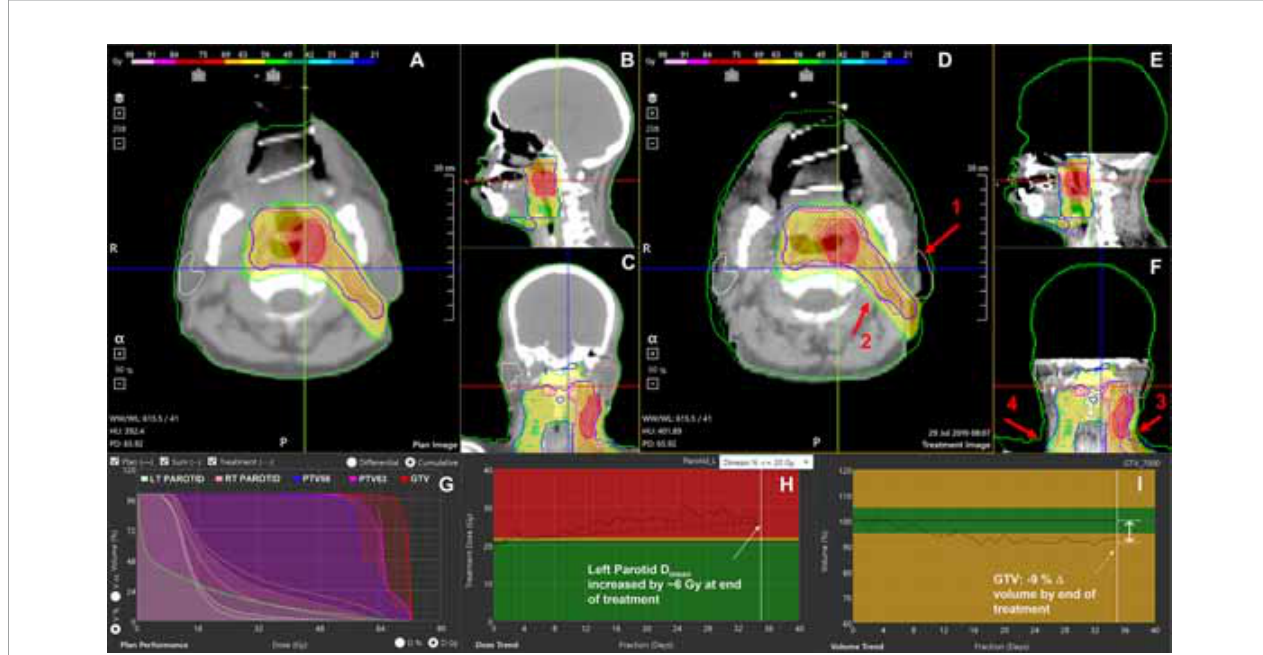
FIGURE 1 | RTapp software user interface. (A – C) Initial plan CT, structures, and 3D dose. (D – F) The fi nal fraction ’ s CBCT with plan structures (solid line), deformed contours to current day ’ s position (dotted line), and initial 3D dose. (G) DVH showing the plan dose (solid line), delivered dose up to the current fraction (DVH sum , dotted line), and day of treatment dose scaled to full treatment (DVH day , dashed line). (H) Trend for parotid ’ s mean dose; (I) tumor volume regression throughout the treatment. The red arrows indicate notable effects of RT and weight loss on the left parotid (1), PTVs (2), external neck contour (3), and inconsistent shoulders repositioning